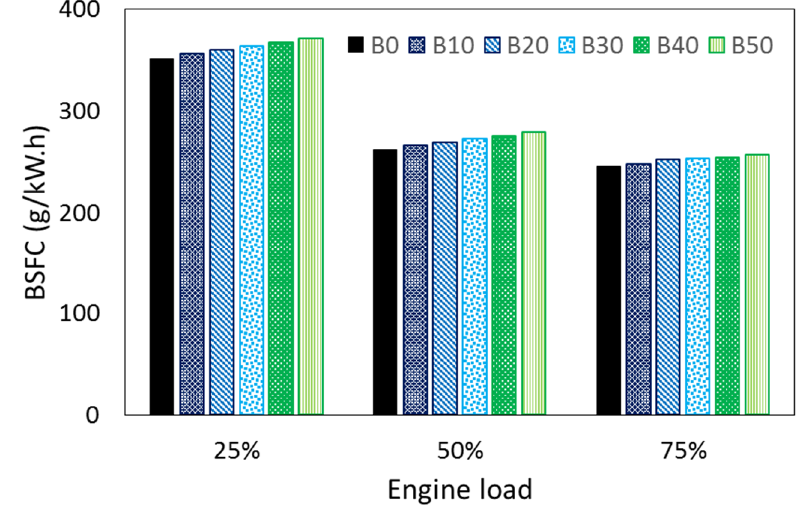
Figure 5. Effect of biodiesel on engine BSFC.